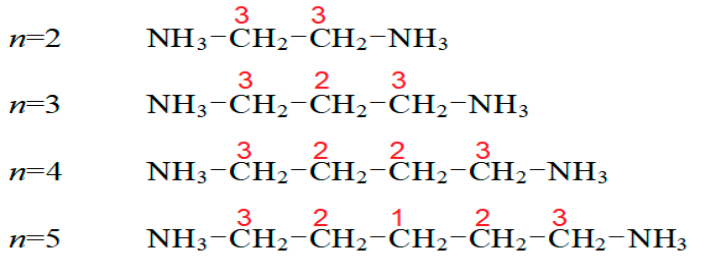
Figure 8. Names of carbons, according to their length, in the cation structure of [NH 3 (CH 2 ) n NH 3 ]CuCl 4. ( n = 2, 3, 4, and 5).